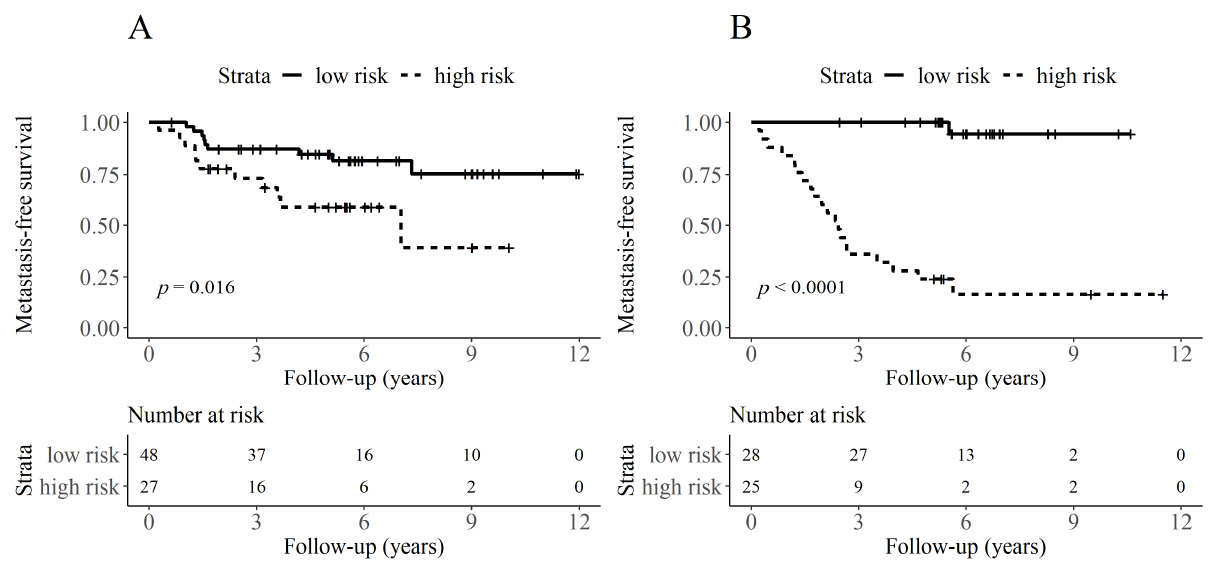
Figure 4. Kaplan-Meier curves for the occurrence of distant metastasis for both UICC stages. Patients are stratified based on the classification of BIg-CoMet for UICC II cases ( p = 0.016) ( A ) and for UICC III cases ( p < 0.0001) ( B ).